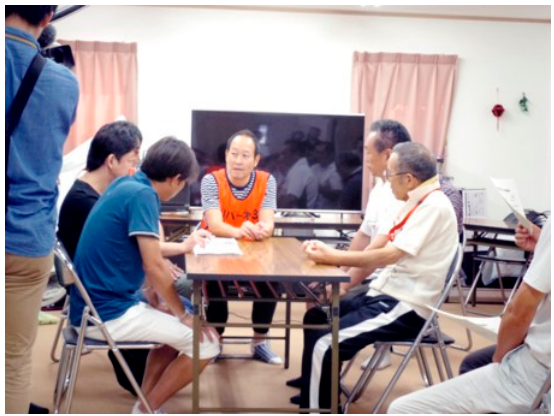
Figure 6. Build-up of a support system for persons who need help in an evacuation.